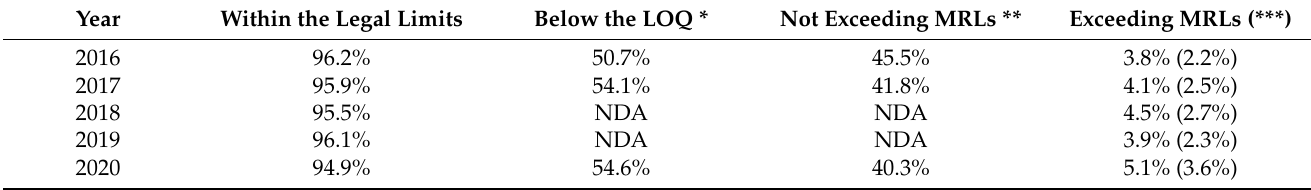
Table 1. The main results presented in annual reports of the European Food Safety Authority on pesticide residues in food in 2016–2020